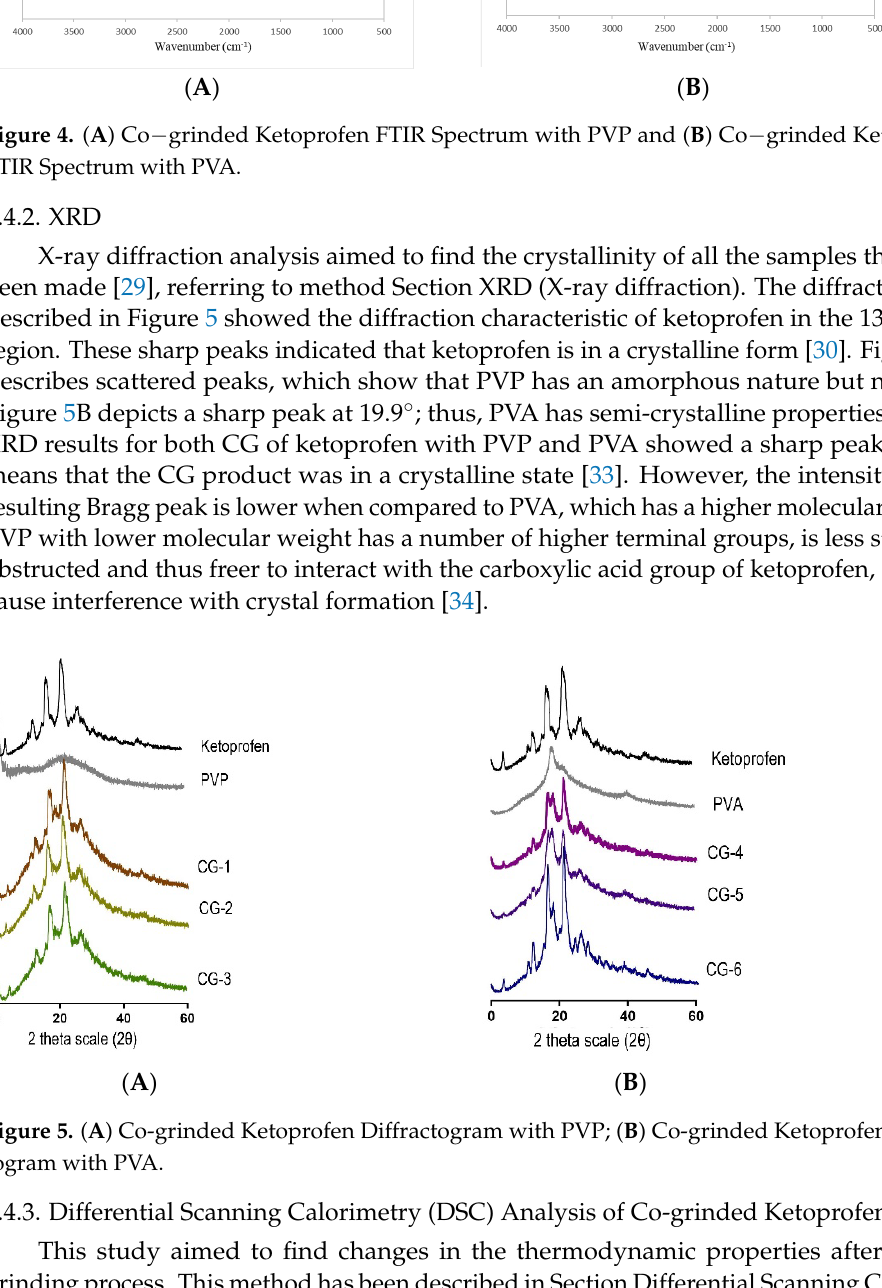
Figure 4. ( A ) Co − grinded Ketoprofen FTIR Spectrum with PVP and ( B ) Co − grinded Ketoprofen FTIR Spectrum with PVA.